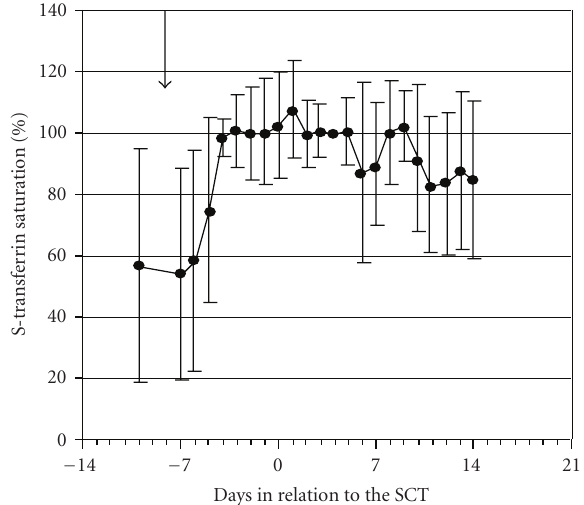
Figure 2: Mean ± SD serum level of the calculated transferrin sat- uration in 10 allogenic SCT patients during the peritransplantation period. Arrow indicates onset of the conditioning regimen [12].